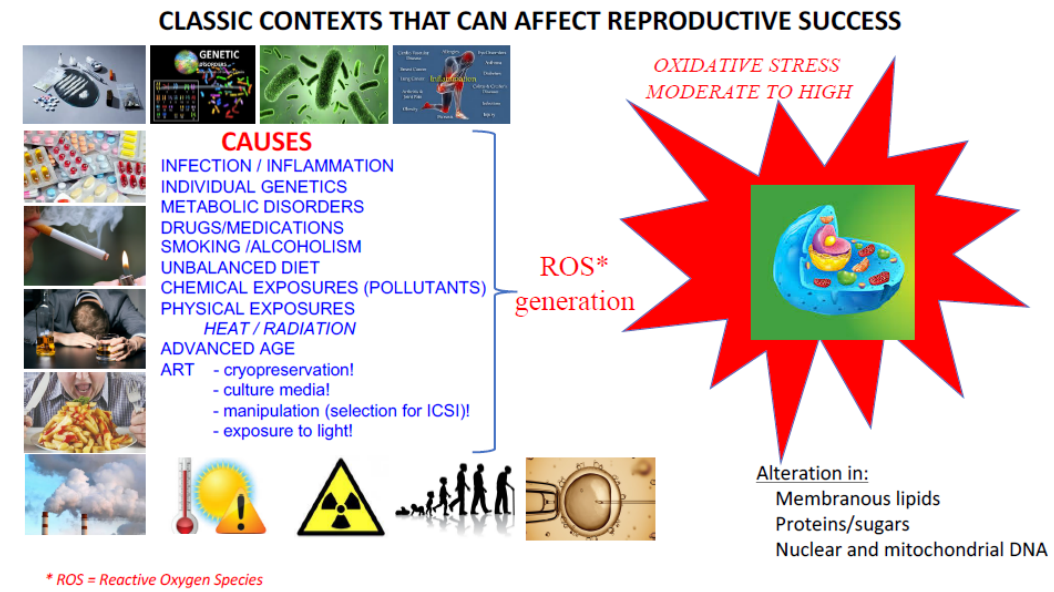
Figure 2. Classic situations promoting the generation of ROS. Situations as varied and cumulative as individual genetic predisposition, infectious/inflammatory pathophysiology or metabolic disorders, medication or addiction (drugs, alcohol, tobacco), nutritional imbalances, exposure to environmental pollutants and physical stresses (such as excessive heat, ionizing radiation) all generate systemic or local ROS that can affect all cells of the body including gametes. Aging is also a situation that promotes oxidative stress. Indeed, according to the “free radical theory of ageing”, the lower efficiency of ROS recycling systems when one ages leads to an inevitable increase in ROS production. Finally, in the very specific context of assisted reproductive technologies (ART), gamete cryopreservation, culture in different artificial media, long gamete selection protocols for in vitro fertilization, intracytoplasmic sperm injection (IVF ICSI) and exposure to light alone are all sources that can lead to a pro-oxidant situation.